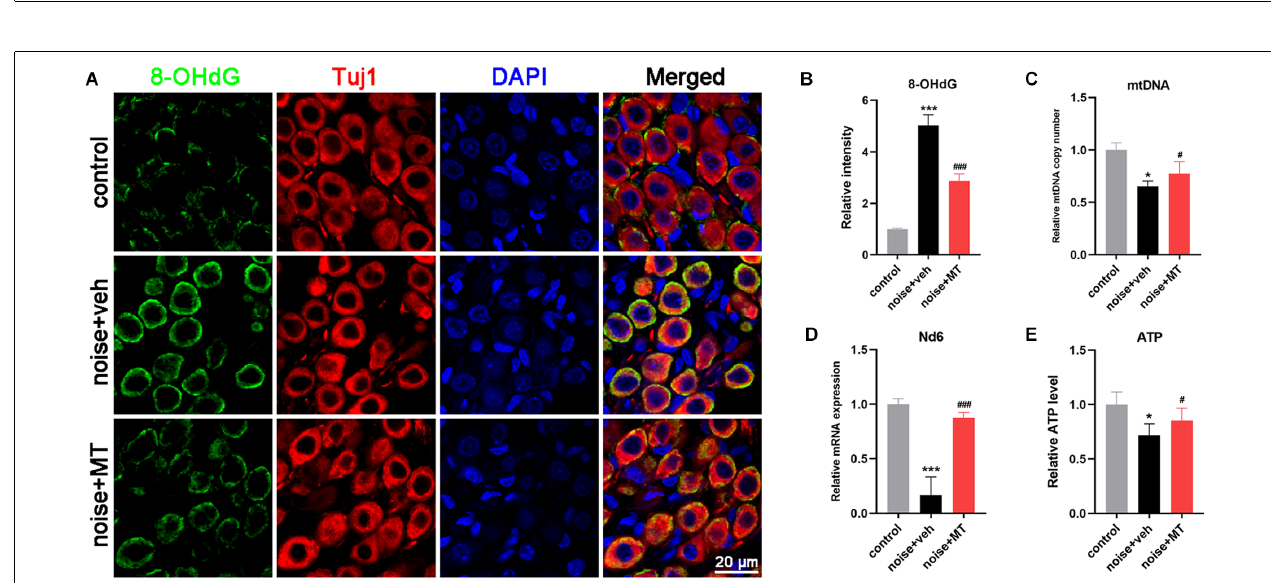
FIGURE 5 | MT treatment mitigated ROS generation in the cochlea. (A) Representative images of 4-HNE (green) and DAPI (blue) fluorescent staining in base turn area of the midmodiolar sections 1 h after the noise exposure. (B) Representative images of DHE (red) and DAPI (blue) fluorescent staining in base turn area of the midmodiolar sections 1 h after the noise exposure. Four cochleae form two animals were used in each group. HCs, hair cells; SV, stria vascularis; SGNs, spiral ganglion neurons; ROS, reactive oxygen species.